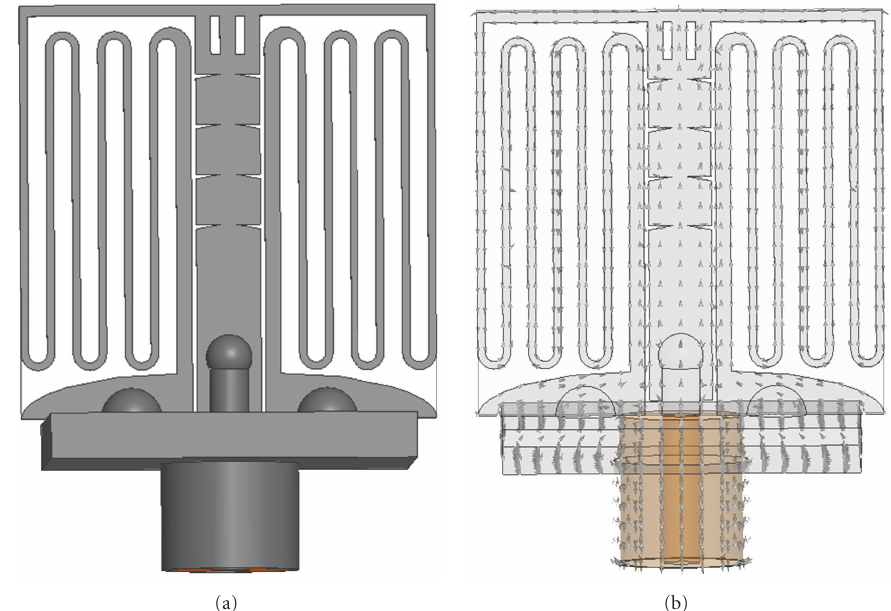
Figure 2: The simulation model of the proposed antenna and the surface current